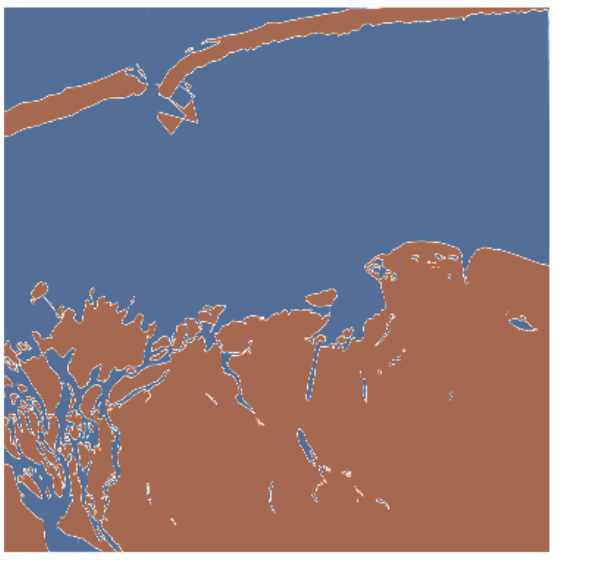
Figure 7. Human annotated dense label for the image in Figure 6. The intensity masks are converted to respective binary masks using thresholds as seen in Section 3.3 for evaluation.